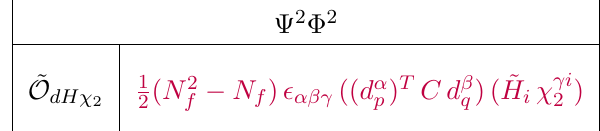
Table 35 . SM extended by Lepto-Quark ( χ 2 ): additional operators of dimension 5. Here i and α, β, γ are the SU(2) and SU(3) indices respectively. p, q = 1 , 2 , · · · , N f are the flavour indices. This operator violates baryon and lepton number.